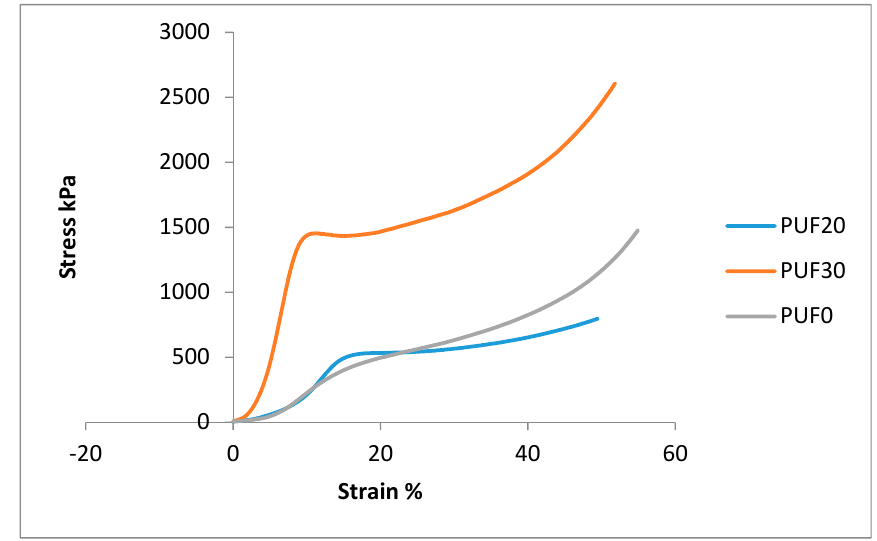
Figure 3. Compressive stress–strain relation for Figure 2. Compressive stress–strain relation for PUF.